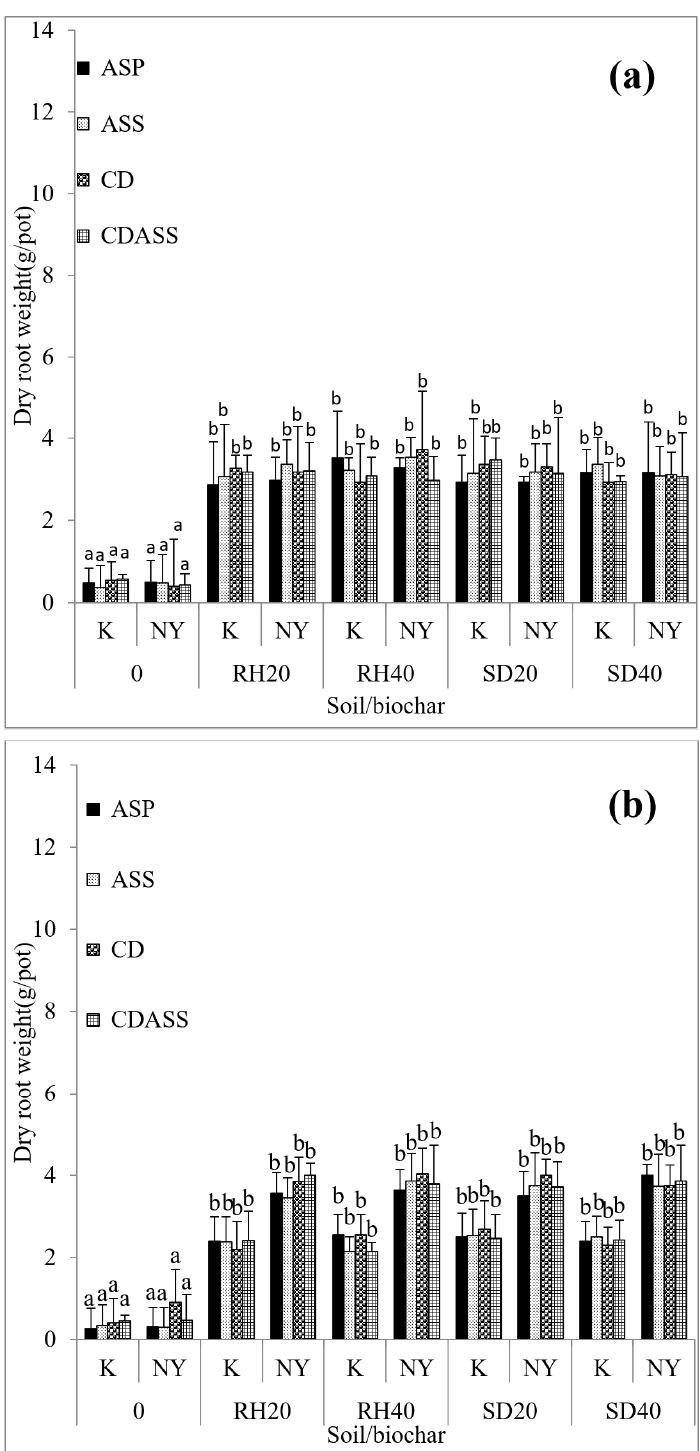
Figure 2. Dry root weights of the maize grown with the different amendments in the ( a ) first and ( b ) second growing seasons. K: Keta series, Ny: Nyankpala series, ASP: Ammonium sulfate fertilizer, ASS: Ammonium sulfate embedded into the biochar, CD: Cow dung, CDASS: Cow dung + Ammonium sulfate embedded into the biochar, RH20: 20 t ha − 1 Rice husk biochar, SD20: 20 t ha − 1 sawdust biochar, RH40: 40 t ha − 1 rice husk biochar, SD40: 40 t ha − 1 sawdust biochar. Values for dry root weight with same letter(s) under the same planting season were not significantly different at p =0.05.